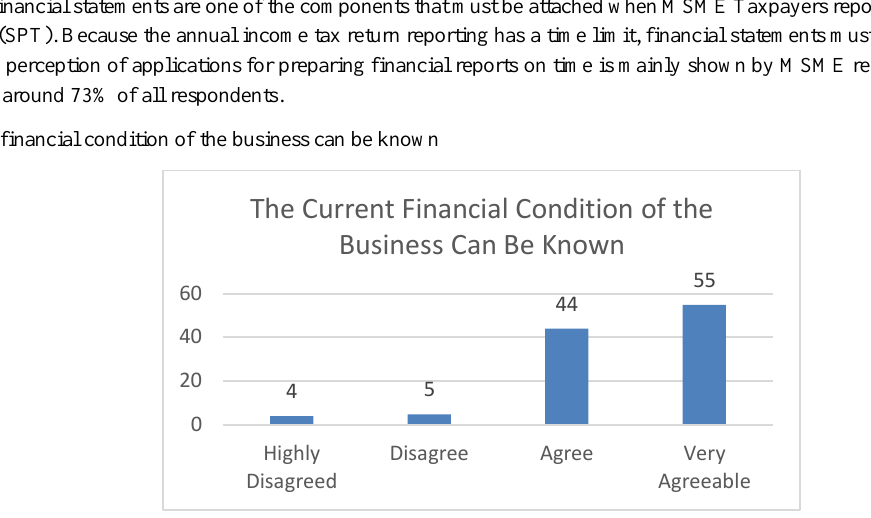
Figure 7: Current Financial Condition of the Business Can Be Known; Source: Own elaboration.